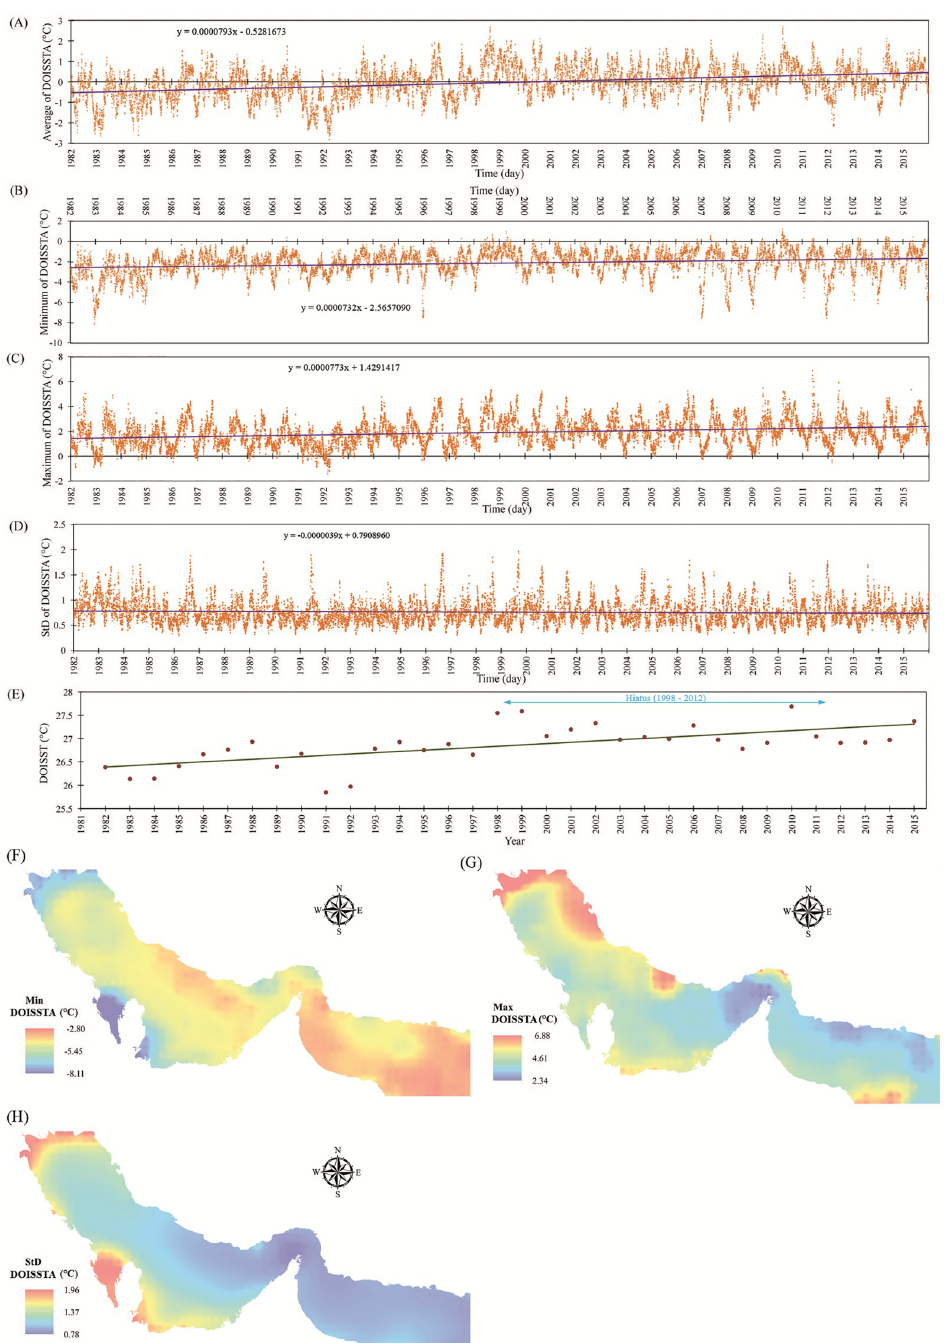
Fig 4. Historical trends in ( A ) mean values, ( B ) minimum values, ( C ) maximum values, and ( D ) standard deviation (StD) values of DOISSTA across the Persian Gulf & Gulf of Oman (PG&GO); ( E ) mean annual values of daily optimum interpolation sea surface temperature (DOISST) across PG&GO; and ( F ) spatial distribution in minimum values, ( G ) maximum values, and ( H ) standard deviation values of DOISSTA across PG&GO.